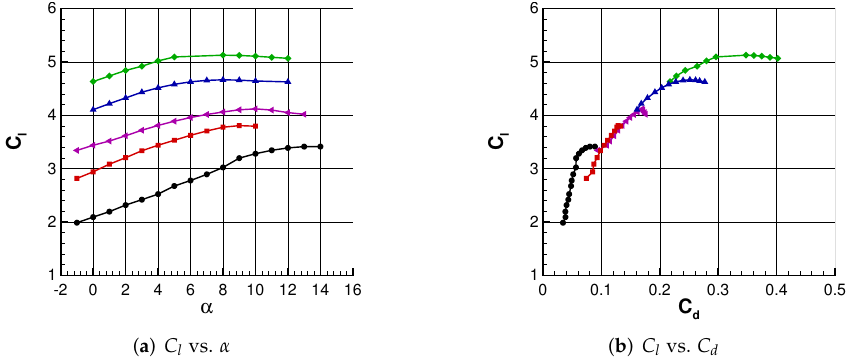
Figure 12. Polar curves comparison of the test cases with NP = 8 with respect to power-off condition ( ● ) . Test case A1 ( ■ ) , D1 ( ◀ ) , E1 ( ▲ ) , and G1 ( ◆ ) .